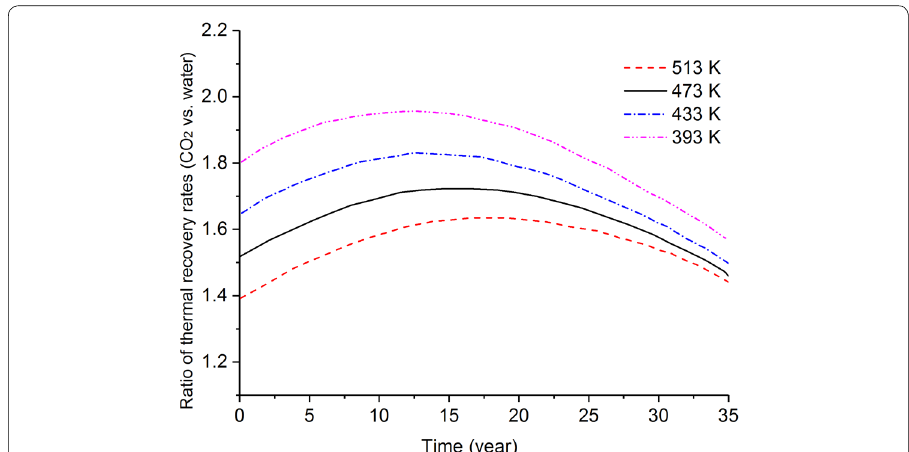
Fig. 7 Ratio of thermal recovery rates of CO 2 to water at different initial reservoir temperatures (Pruess